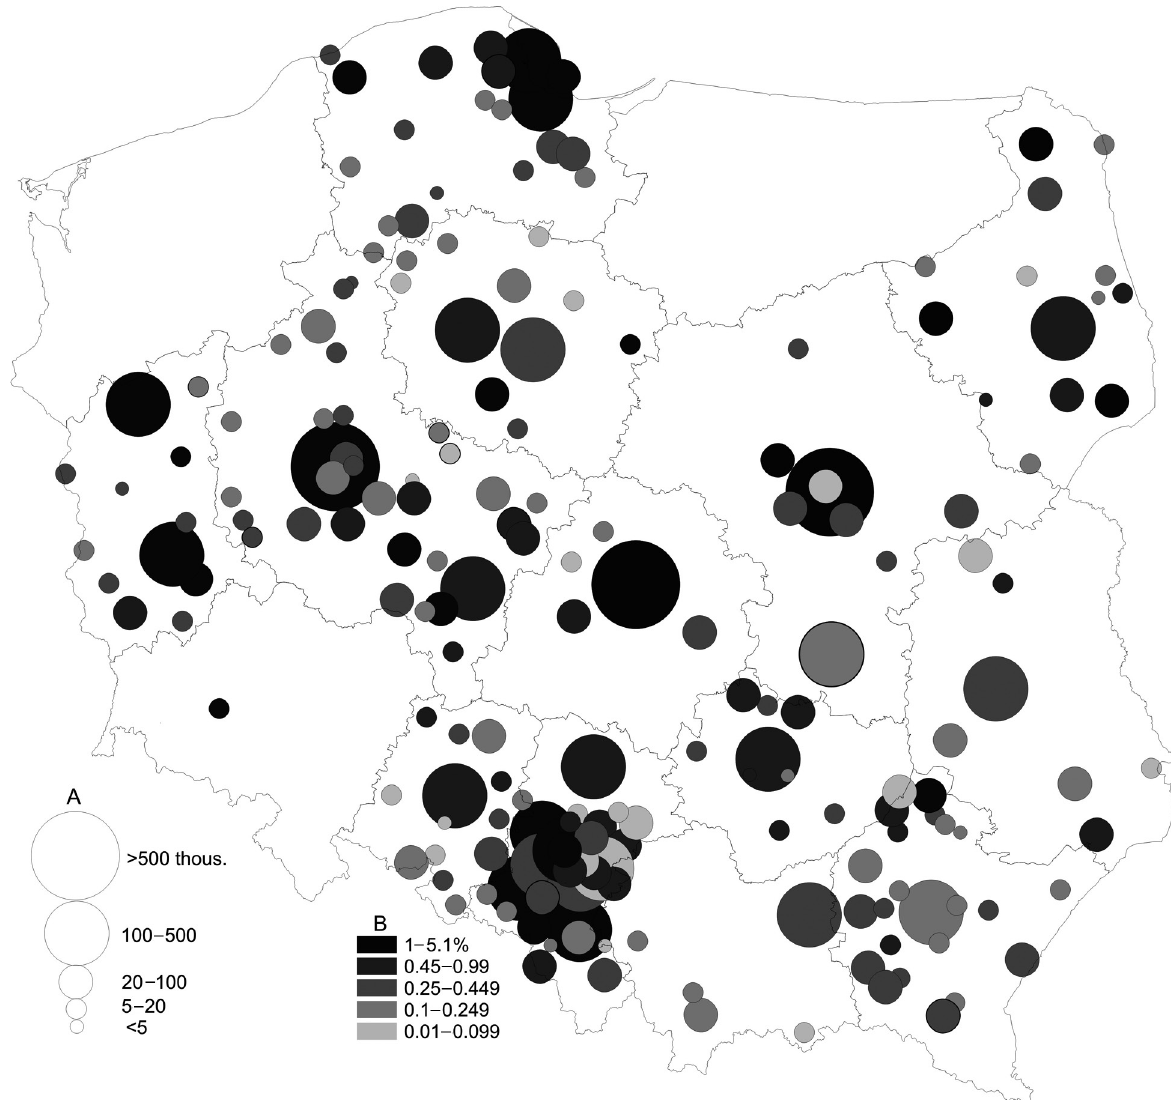
fig. 3. TI projects involving public buildings in Polish towns as percentages of the total value of TI projects co-funded by the rOPV (2007–2013), as of 31 December 2012. Explanation: A – town-size structure by population number; B – TI projects involving public buildings subsidised by the rOPV (2007–2013) as percentages of the total value of TI projects. Source: developed by the authors on the basis of data available from the LDB CSO and European Funds